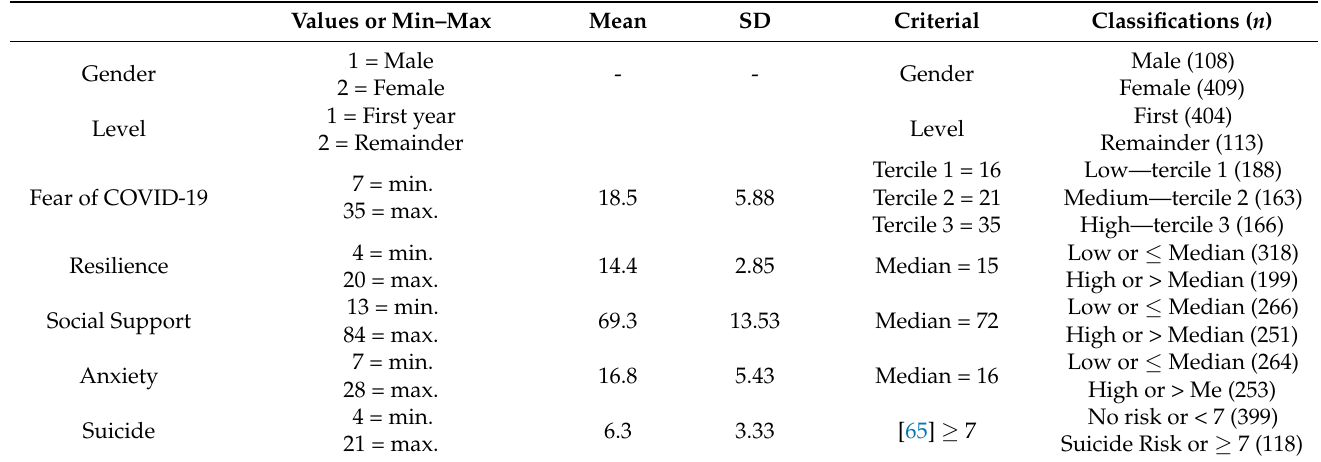
Table 1. Description and classifications of all variables ( N = 517).